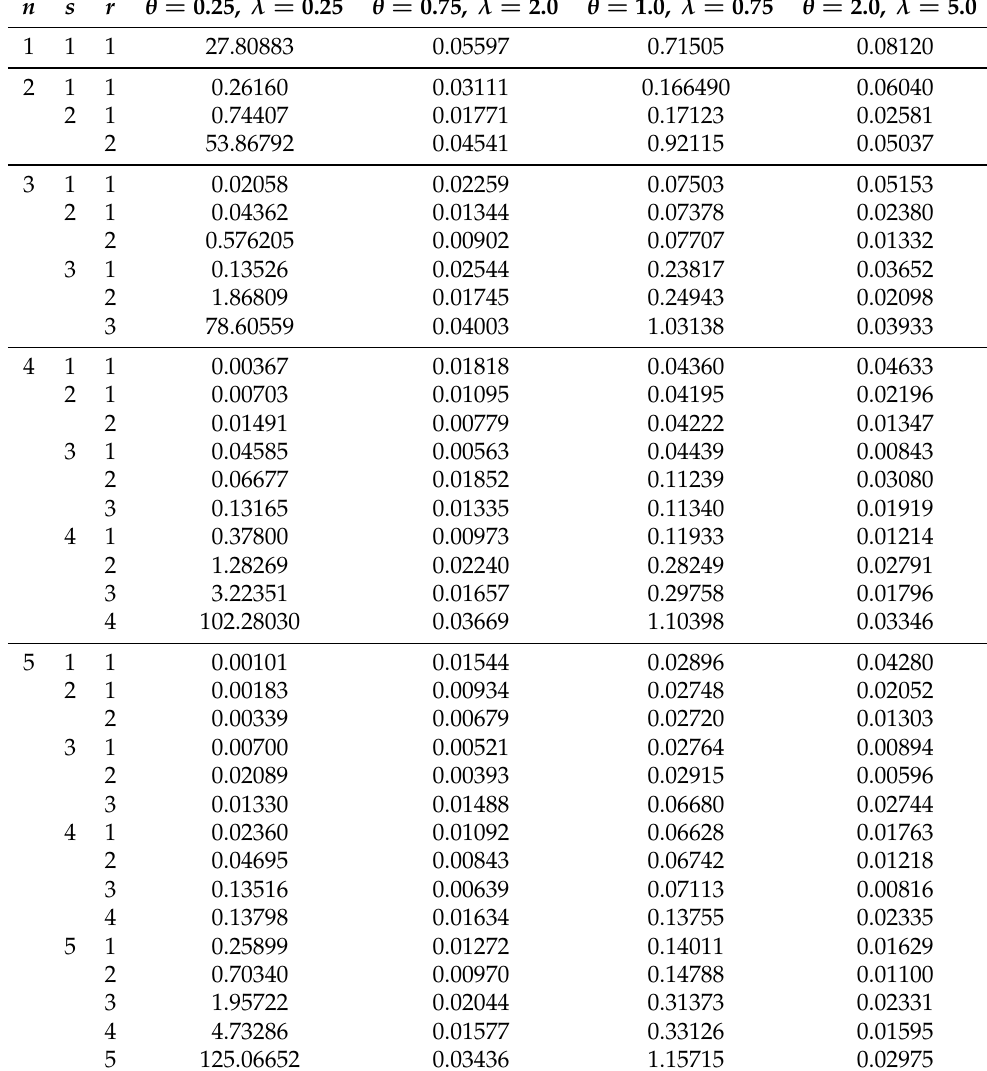
Table 2. Variances and covariances of order statistics for the GB( θ , λ )